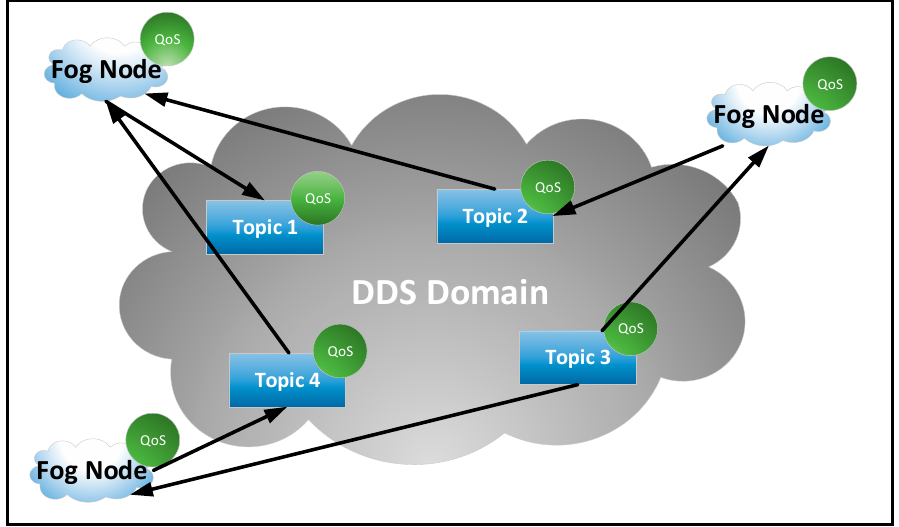
Figure 2. An example of interconnections between fog nodes via data distribution service (DDS) middleware.